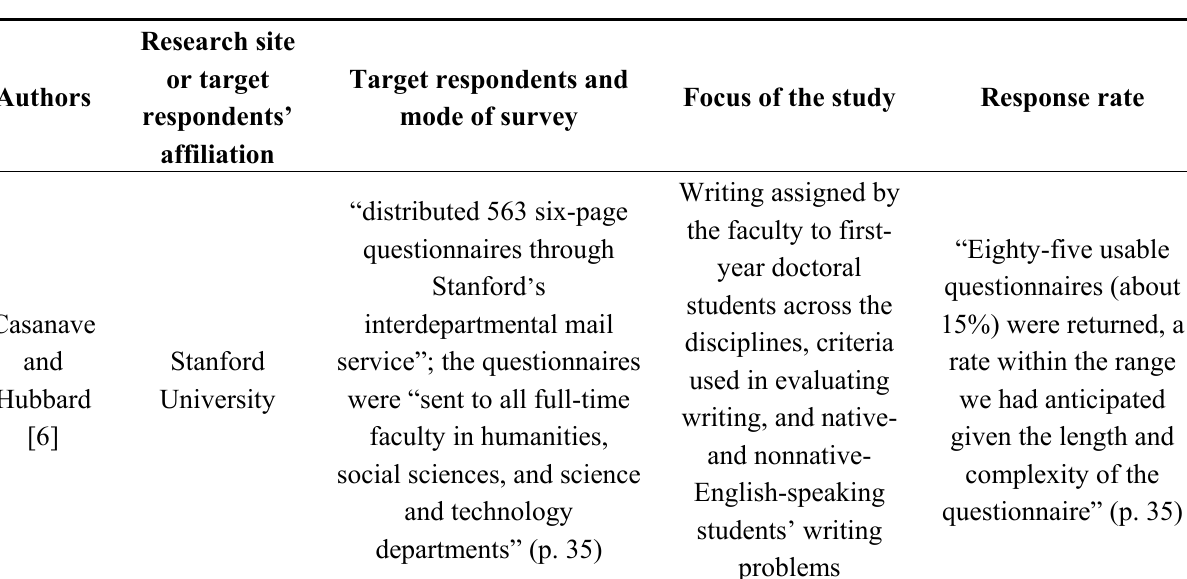
Table 1. A summary of five surveys conducted by language professionals